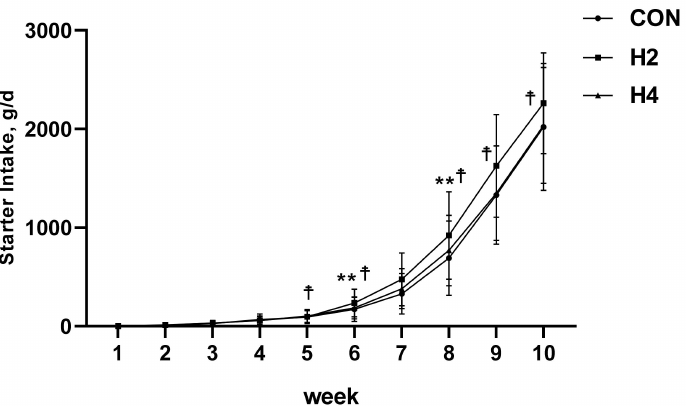
Figure 3. Starter intake for Holstein female calves fed a basic diet without (CON: solid circles; n = 70) or with hay inclusion from the second (H2; Solid squares; n = 70) or fourth (H4; Solid triangles; n = 70) week of age. Differences between CON and hay groups are represented by an asterisk ( p < 0.05, denoted by **). Differences between H2 and H4 are represented by a cross ( p < 0.05, denoted by ☨ ).